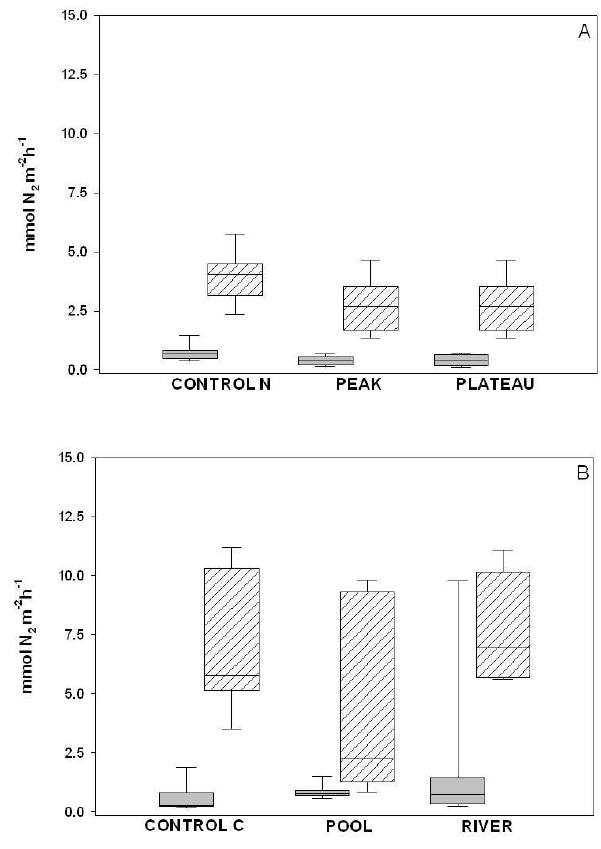
Fig. 3. Denitrification rates as measured over five days in (A) Ex- periment 1: NO − and (B) Experiment 2: DOM changes. Grey boxes Figure 3. Denitrification rates as measured over 5 days in (A) Experiment 1: NO3 and (B) 3 are measurements from the disconnected site, hatched boxes from Experiment 2: DOM changes. Grey boxes are measurements from the disconnected site, the restored site. Whiskers extend to the 95th and 5th percentiles. N = hatched boxes from the restored site. Whiskers extend to the 95th and 5th percentiles. N=33